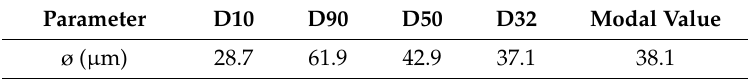
Table 3. Characteristic particle size distribution values of the AISI 316L powder feedstock.